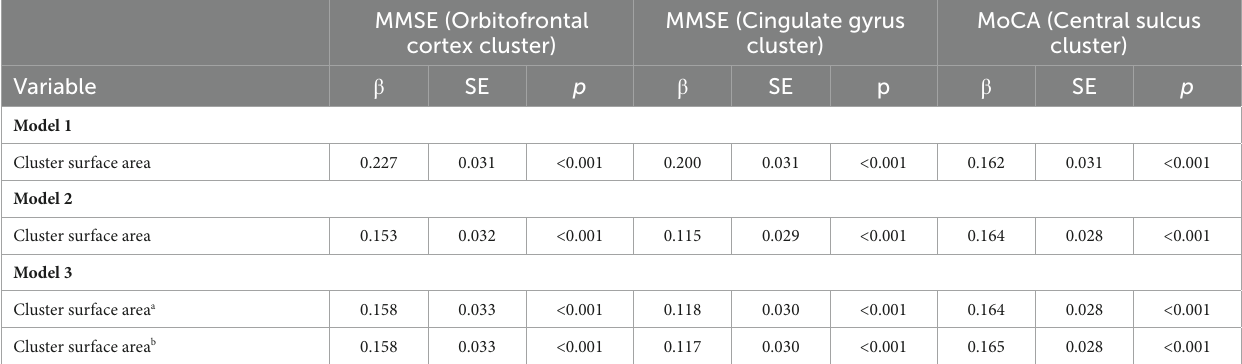
TABLE 3 Association of surface area in three clusters with MMSE and